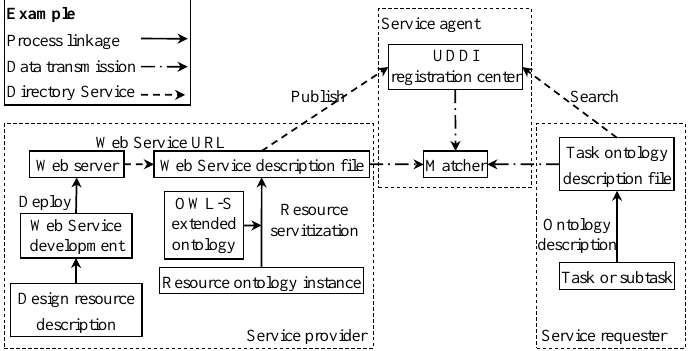
Figure 4. The universal matching process of ontology task and semantic web